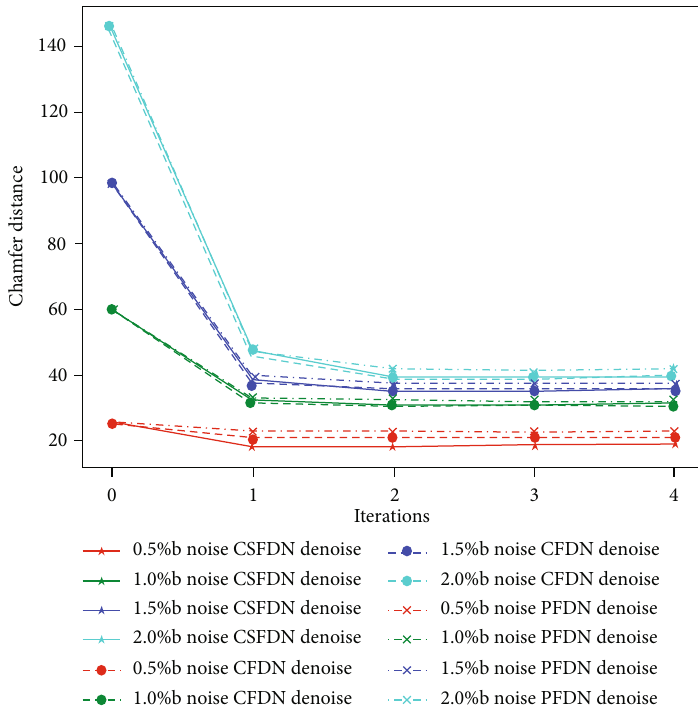
Figure 20: The relationship between residual noise and number of iterations. Three denoising networks are trained only on the basic training set (Section